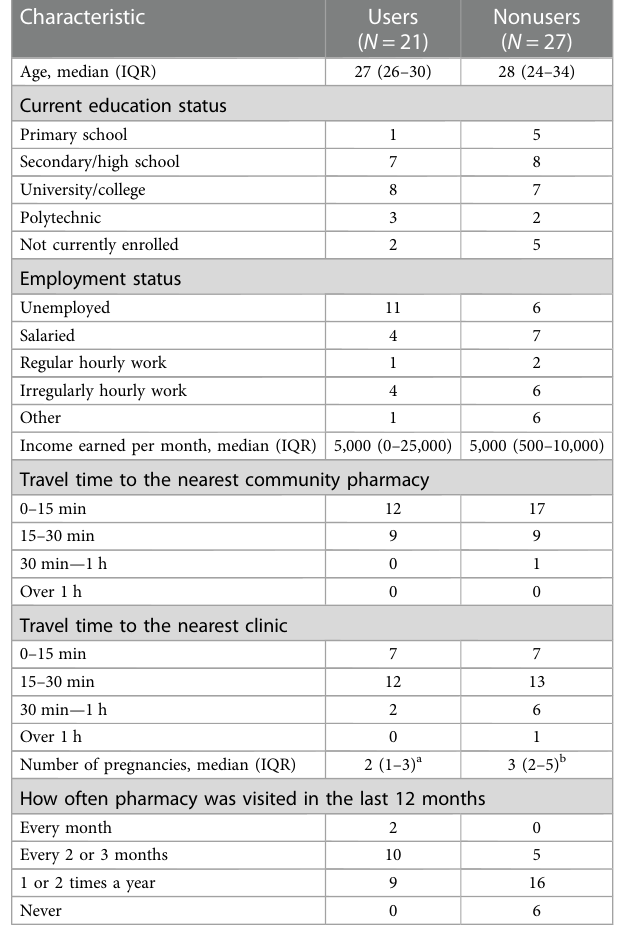
TABLE 1 Characteristics of users and nonusers of pregnancy tests.